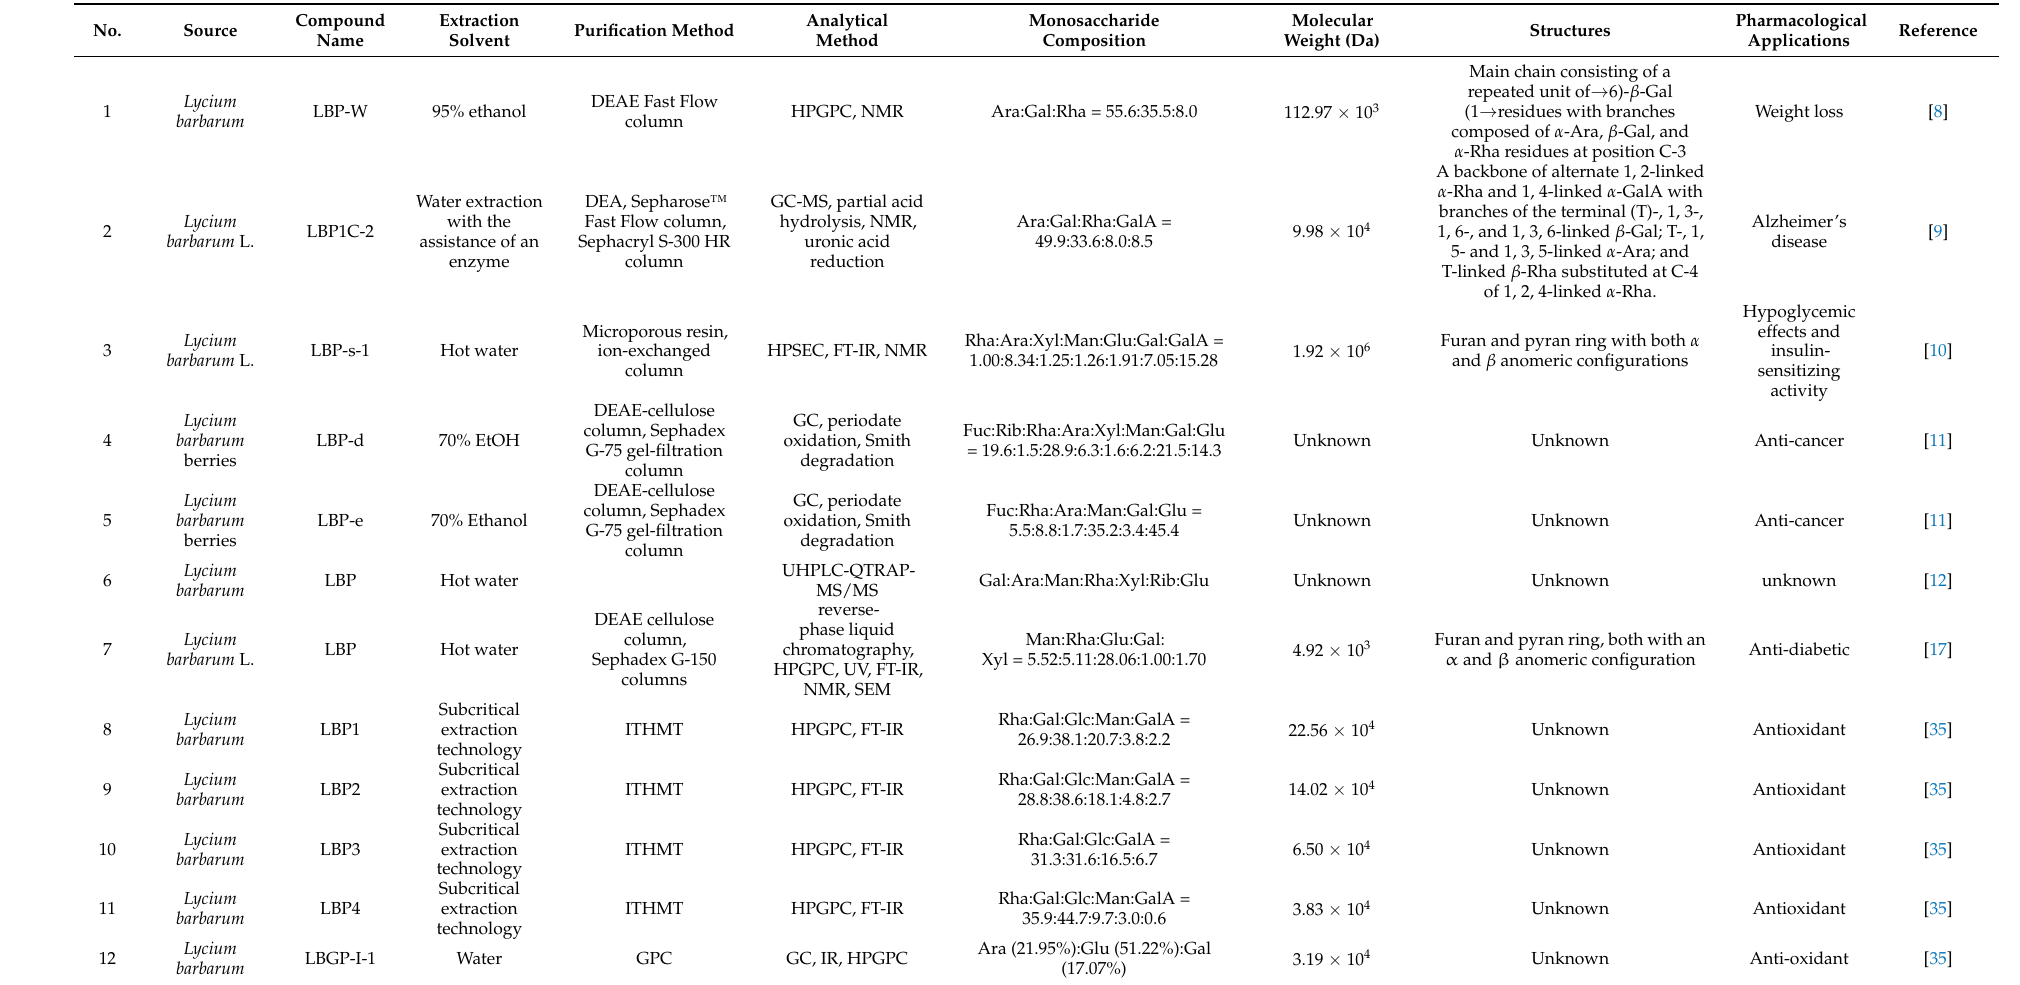
Table 4. The summary of the structural features and biological activities of